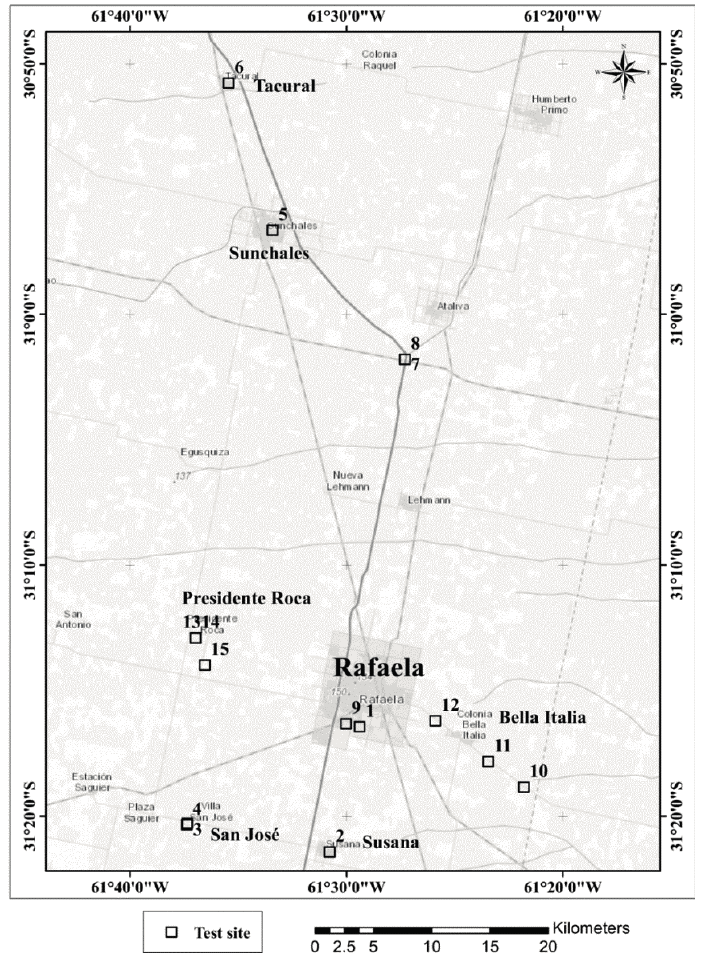
Figure 1. Sampling sites near Rafaela (Santa Fe Province,